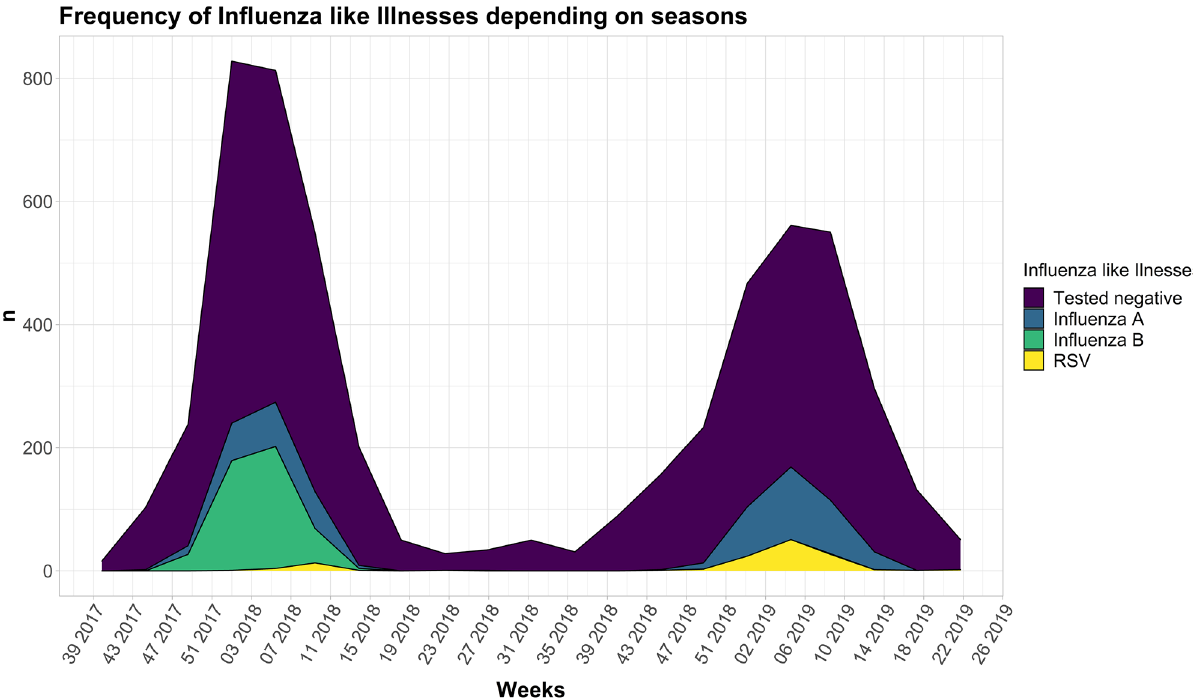
Figure 2. Demonstrates the frequency of influenza like illnesses depending on the seasons 20